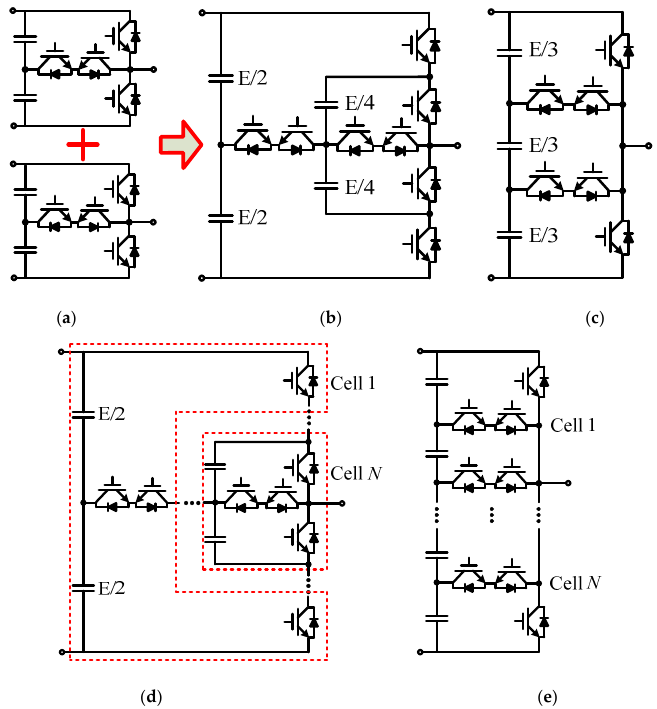
Figure 6. Derivation process of hybrid multilevel converters. ( a ) 3L T-type cell [18], ( b ) 5L SM converter, ( c ) 4L π‐ type converter [31], ( d ) general topology of SM converter, ( e ) general topology of π‐ type converter.